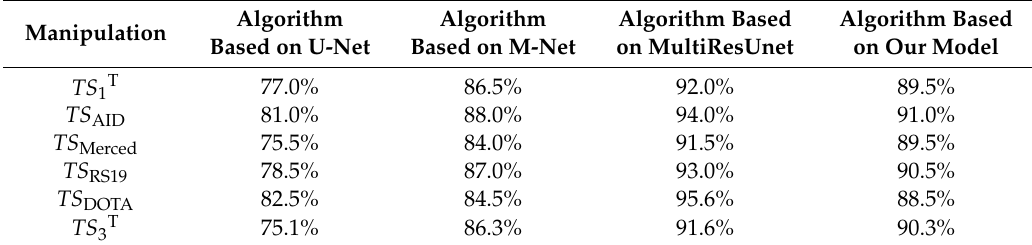
Table 4. Comparison of robustness test of JPEG compression ( T h is set to 0.02). Manipulation